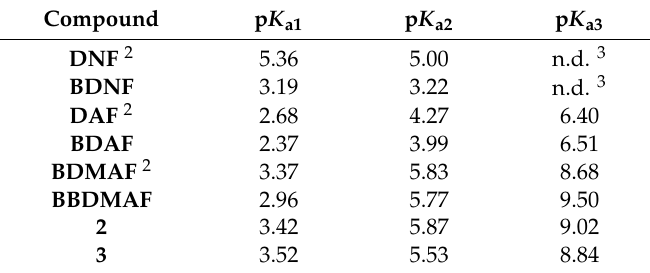
Table 1. Acidity constants of fluorescein derivatives 1 .